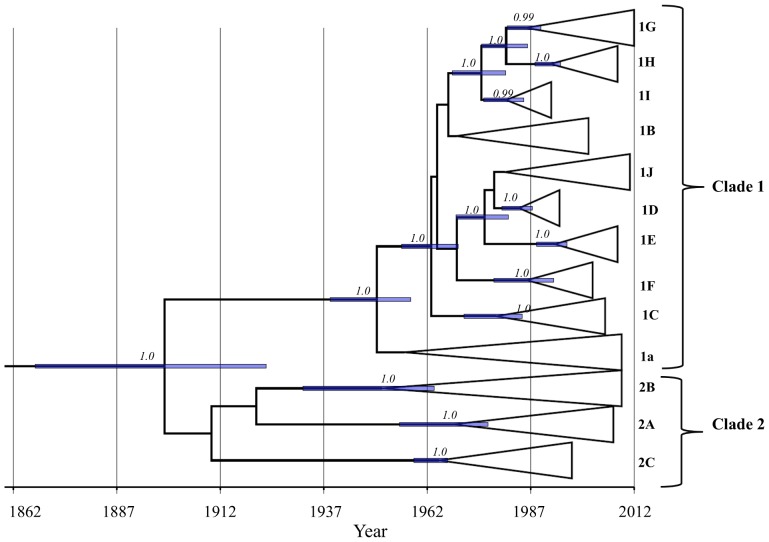
Maximum clade credibility (MCC) tree depicting TMRCA estimates of respective genotypes.Posterior probability of each node is shown. The horizontal bar at each node is the 95% HPD interval for the TMRCA of the respective node. Time-scale (in year) is shown at the bottom of the tree.